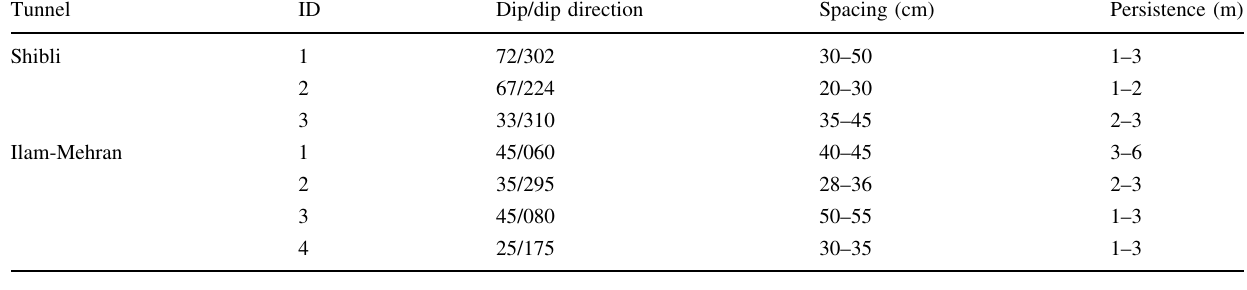
Table 3 Discontinuity sets properties